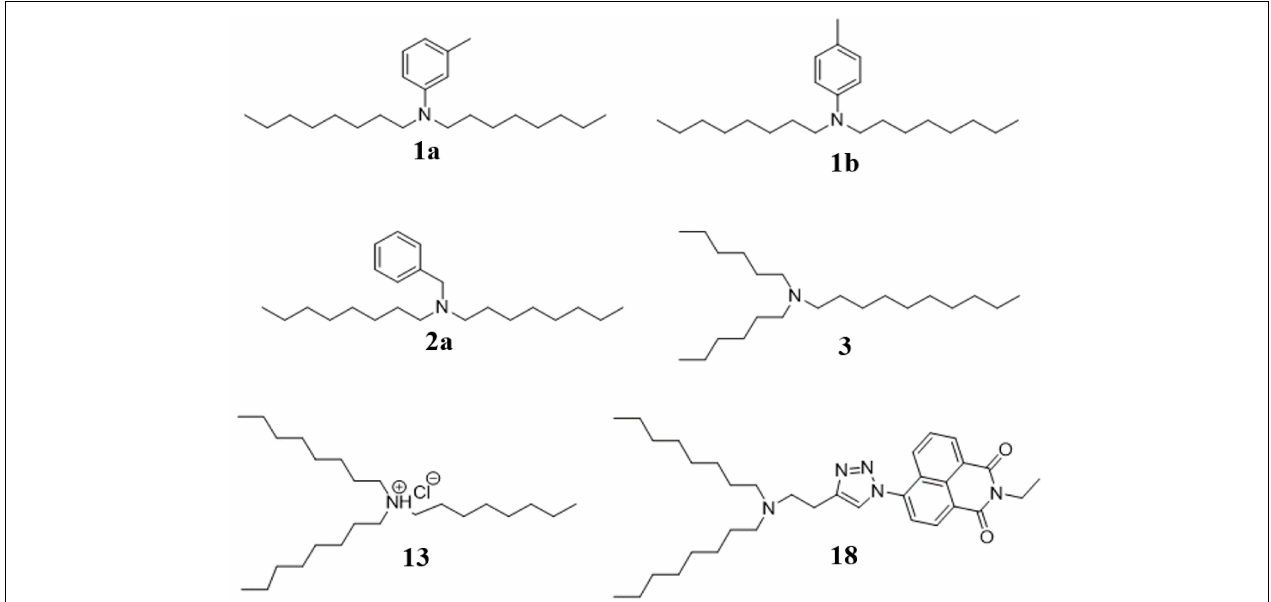
FIGURE 1 | Synthesis structures of bioactive amine natural products identified as new compounds in this study.